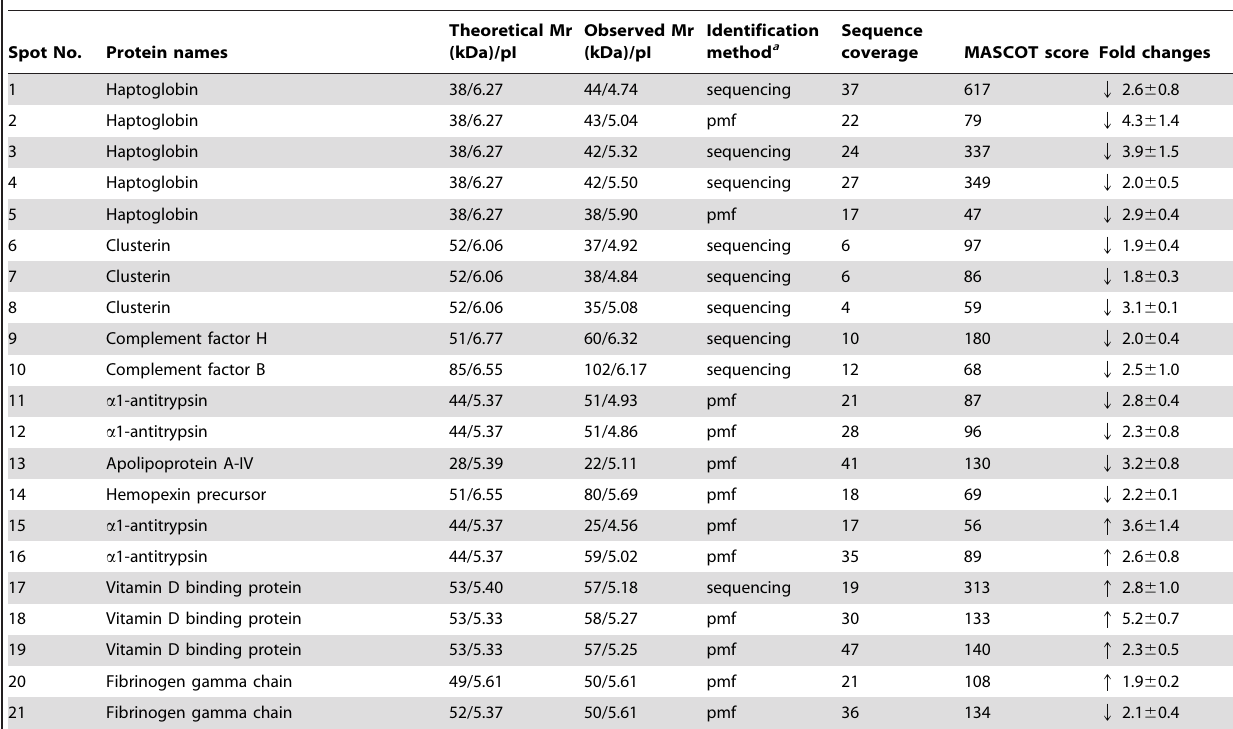
Table 2. Lists of differentially expressed proteins in the plasma of long-term HD compared to the short-term HD patients.